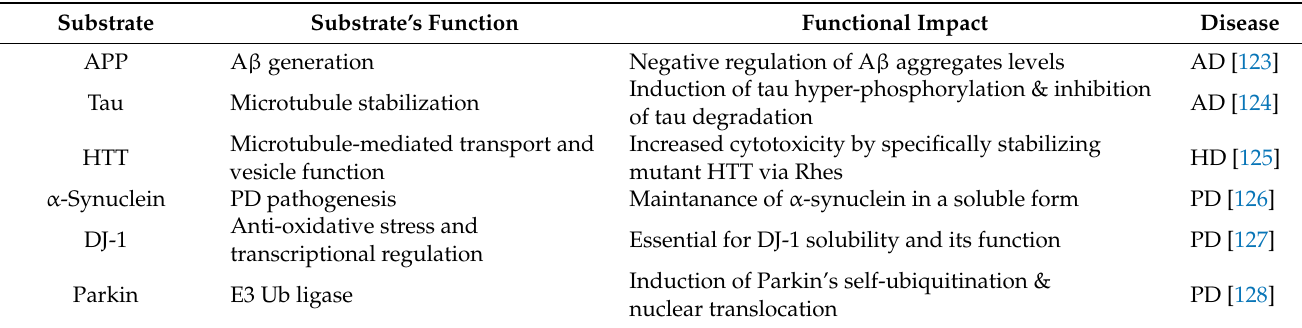
Table 7. Neurodegenerative disease-related key protein regulated by